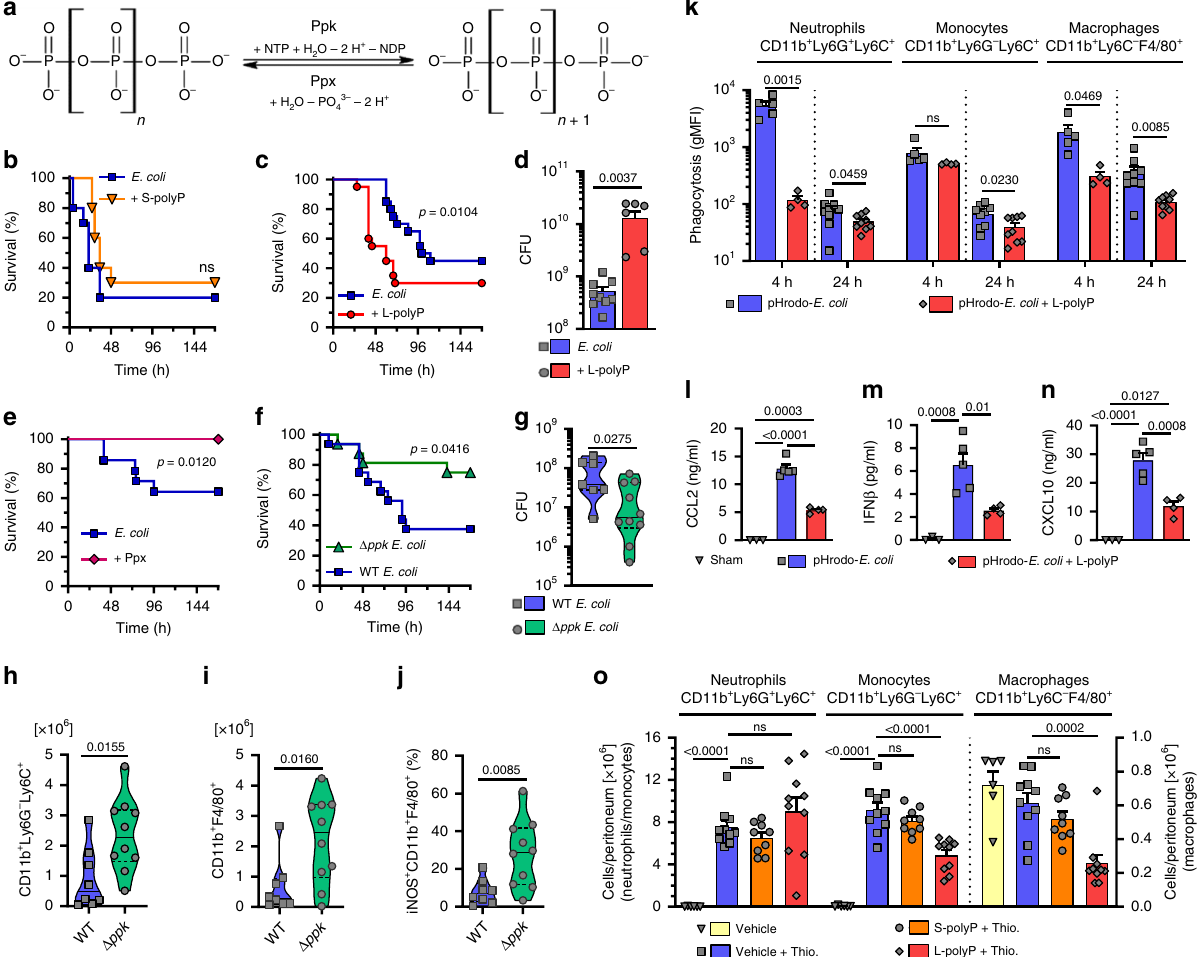
Fig. 1 Bacterial polyphosphates impair sepsis survival and myeloid cell responses. a Bacterial polyphosphate metabolism, Ppk polyphosphatekinase,